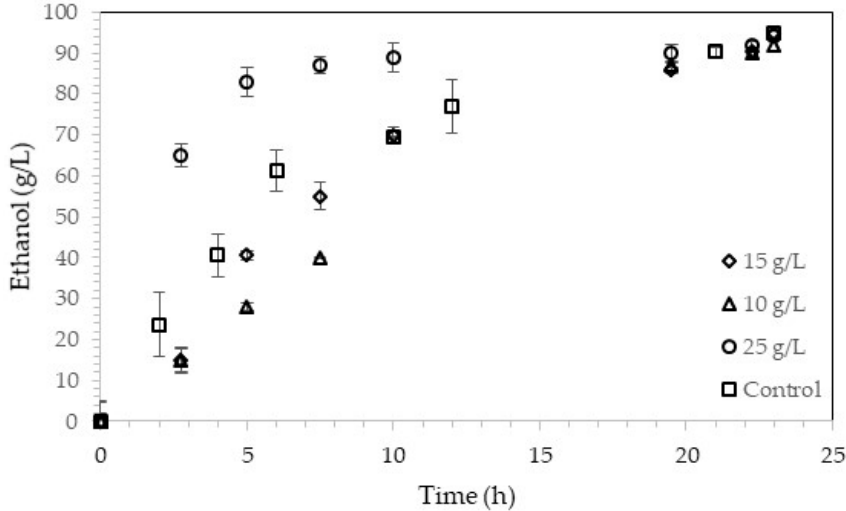
Figure 5. Fermentation kinetics of the aqueous extracts with free cells of Saccharomyces cerevisae .